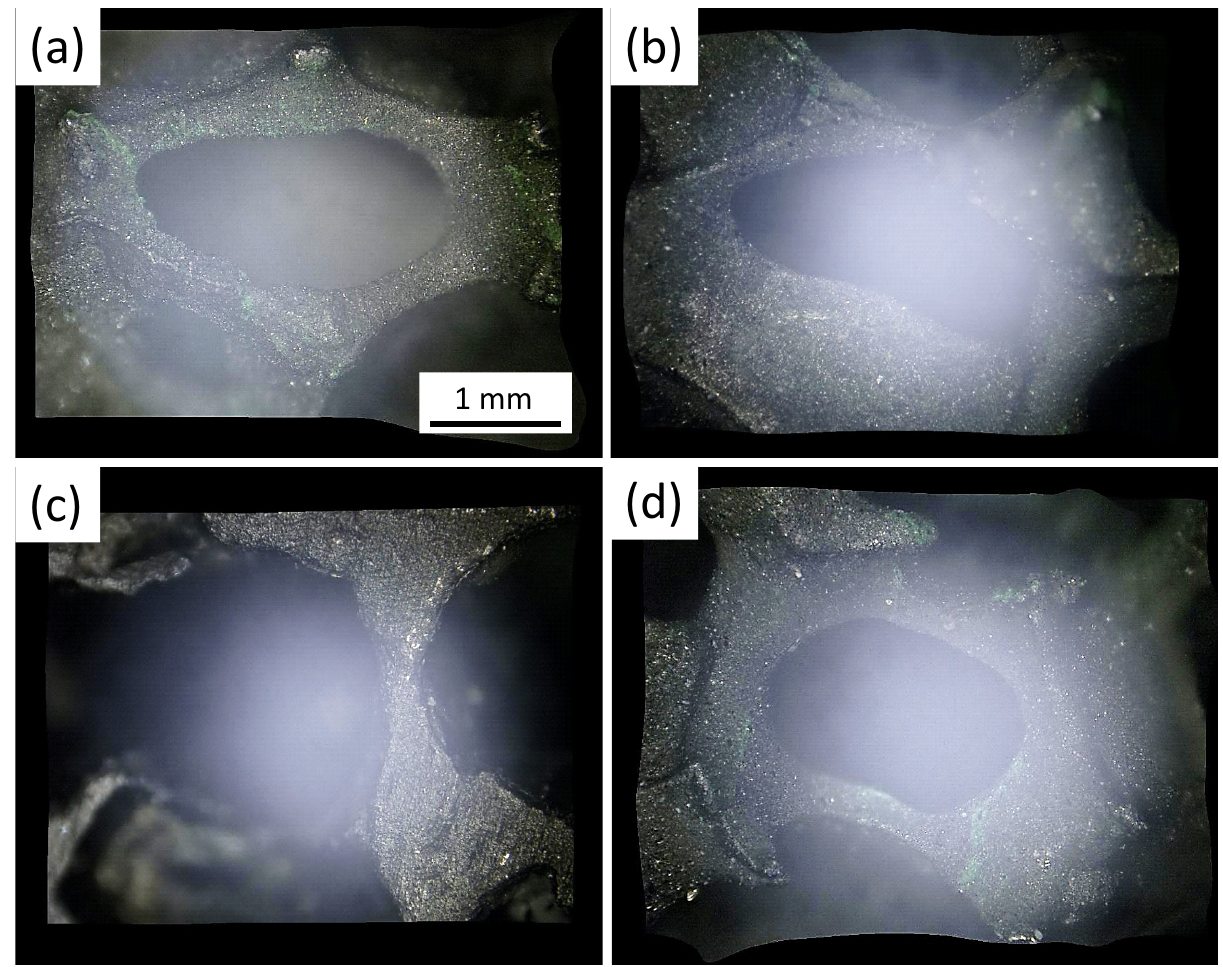
Figure 5. ( a – d ) Optical raw images of foam struts, ligaments and windows in various positions within the bulk foam sample taken by a Keyence VHX-5000 microscope, allowing a large focal depth. These images provide an impression of the local variation of the foam windows, struts and ligaments, which need to be